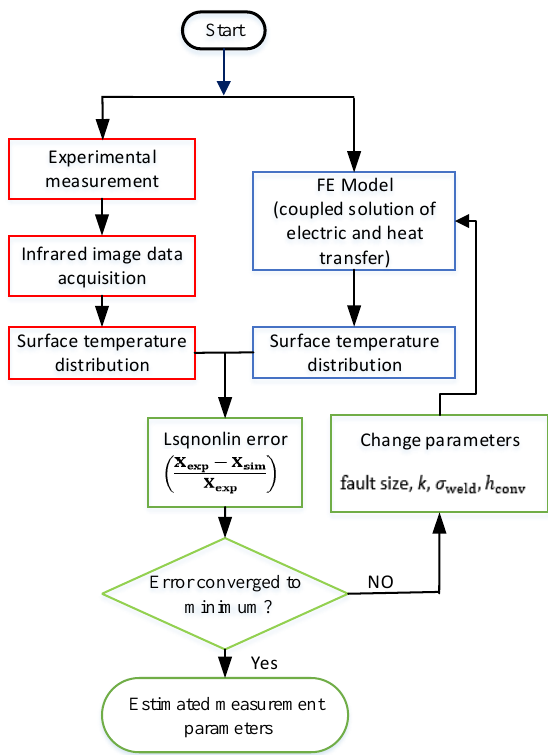
Figure 6. Inverse model algorithm flowchart.